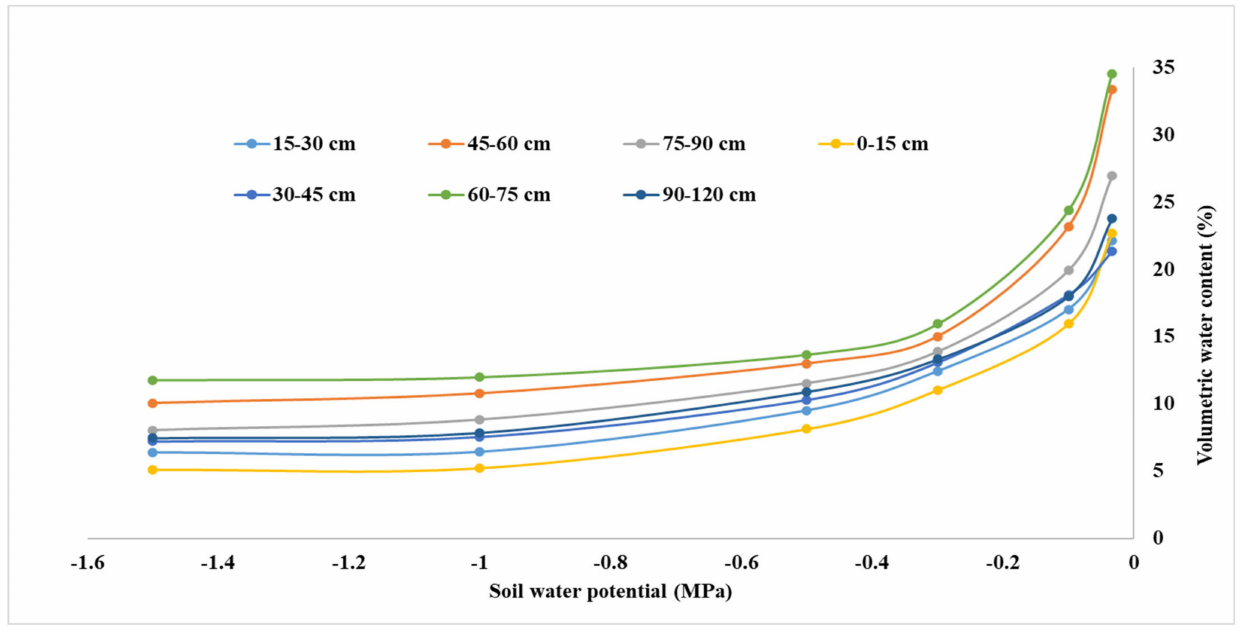
Figure 2. Soil moisture characteristics curve of the experimental site, showing the curves for seven different